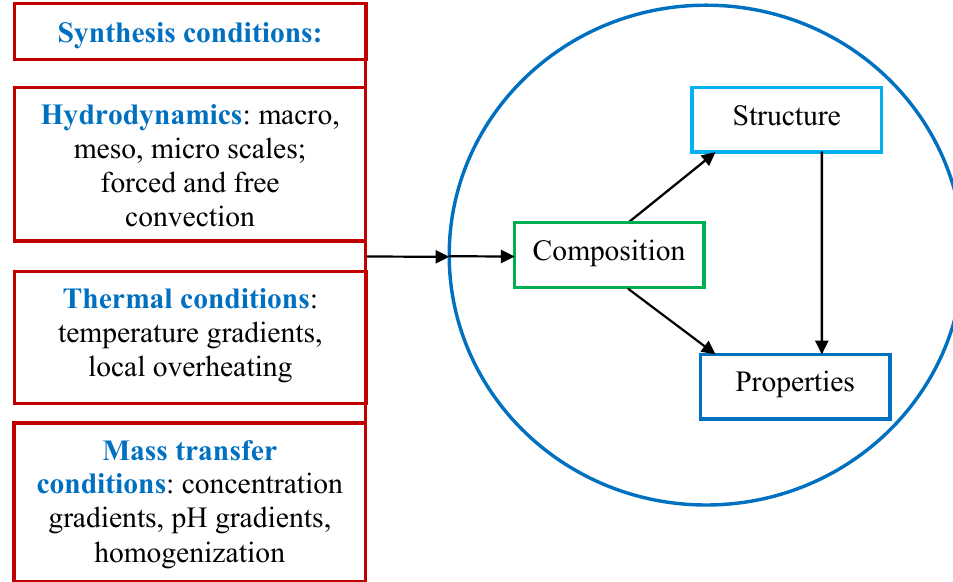
Figure 1. Block diagram of the effect of synthesis conditions on the composition, structure, and properties of nanoscale materials.